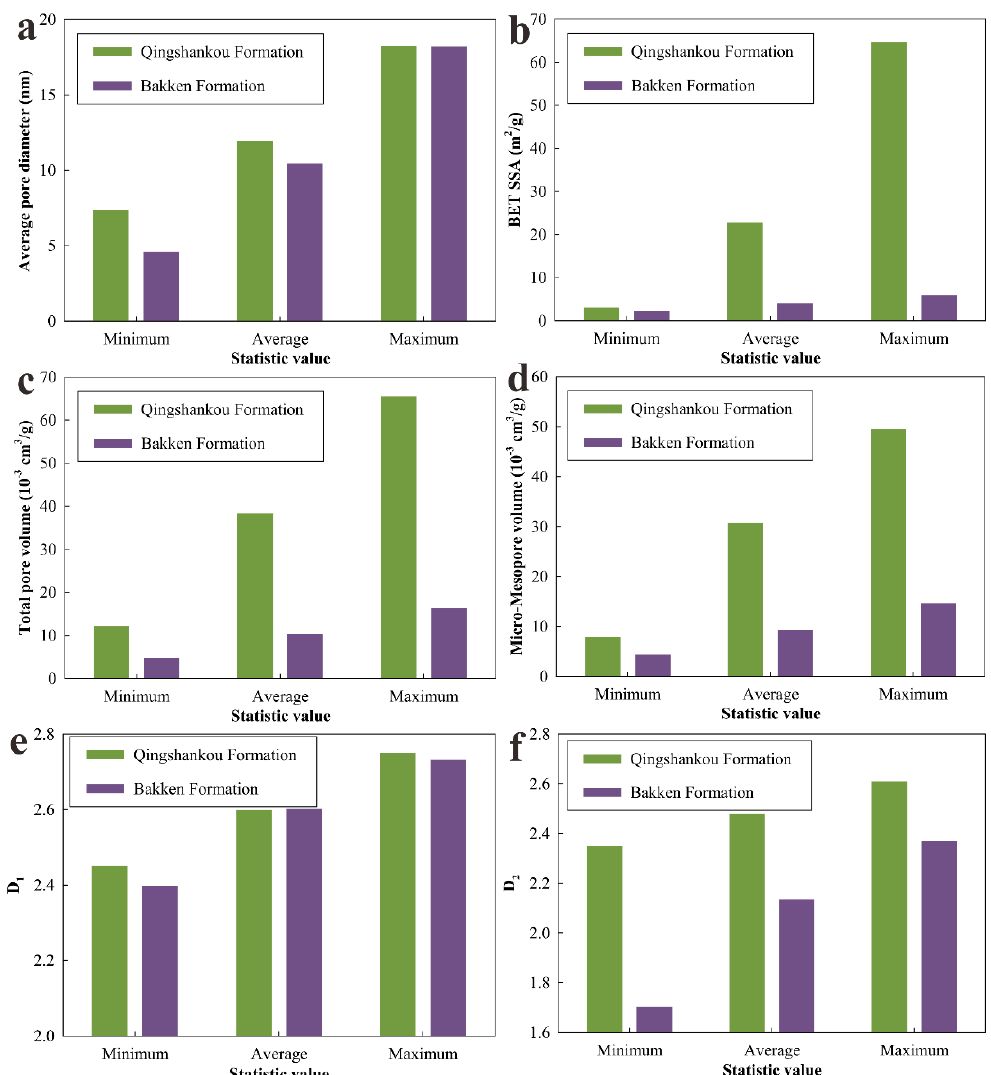
Figure 12. The statistic values of pore structure parameters and fractal dimensions in the Qingshankou Formation and Bakken Formation. ( a ) Average pore diameter; ( b ) BET SSA; ( c ) tota pore volume; ( d ) micro-mesopore volume; ( e ) D 1 ; and ( f ) D 2 .